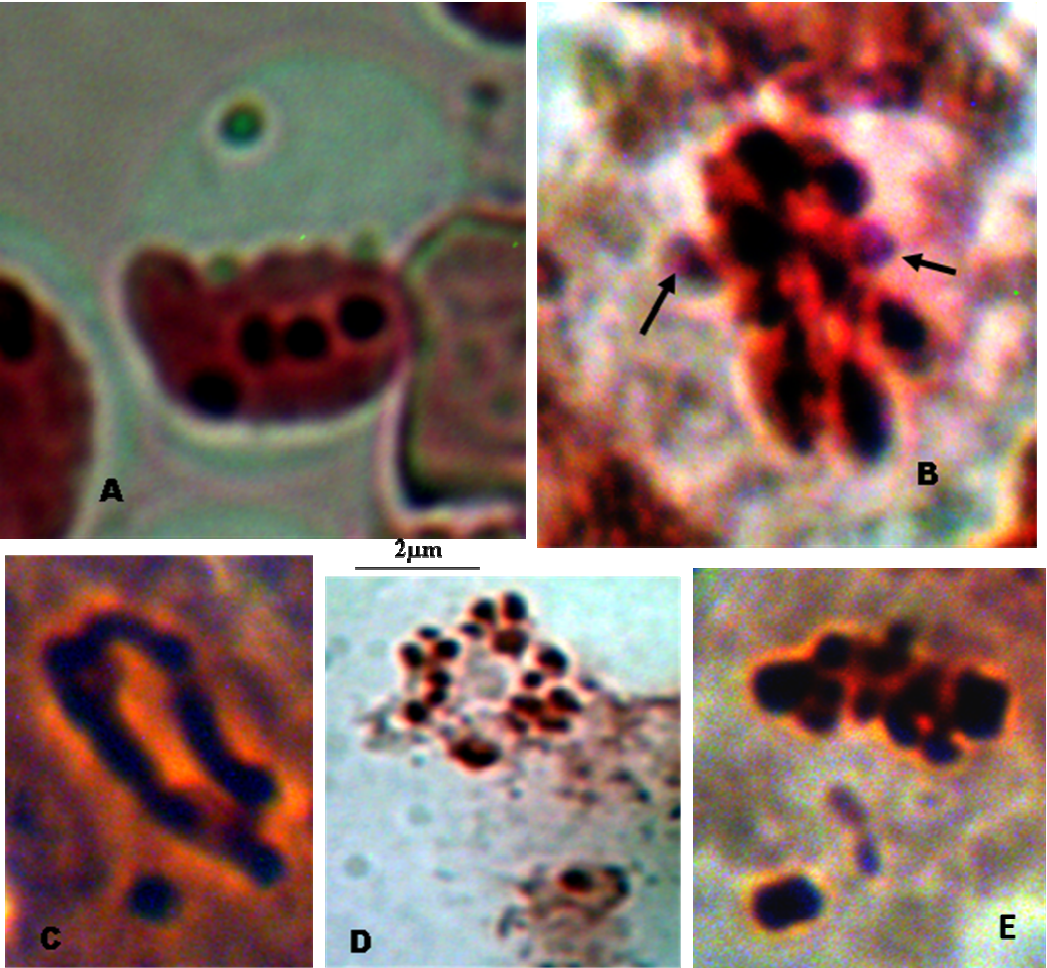
Fig. 4. Chromosomes of the moss species studied. A: Metaphase I of Hyophila crenulata showing 4 bivalent (4II) chromosomes (i.e. n = 4); B: Metaphase I of Thuidium gratum showing n = 12 (10 + 2m) chromosomes (m-chromosomes arrowed); C: Mitotic metaphase of Barbula lambarenensis showing 2 n = 6 chromosomes; D: Mitotic metaphase cell of Stereophyllum nitense showing 2 n = 18 chromosomes; E: Metaphase I cell of Bryum coronatum showing n = 10